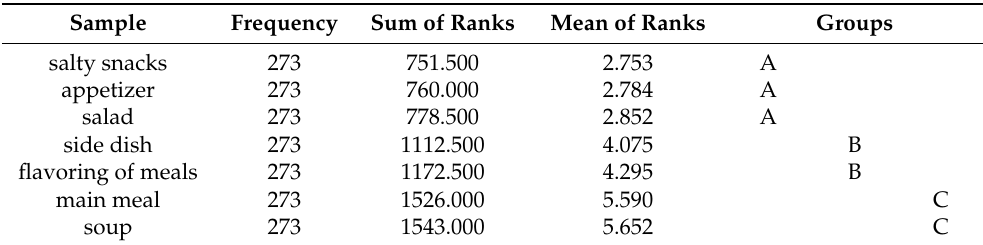
Table 4. Differences in the evaluation of preferred mushrooms meals in the “occasional con- sumers” segment.